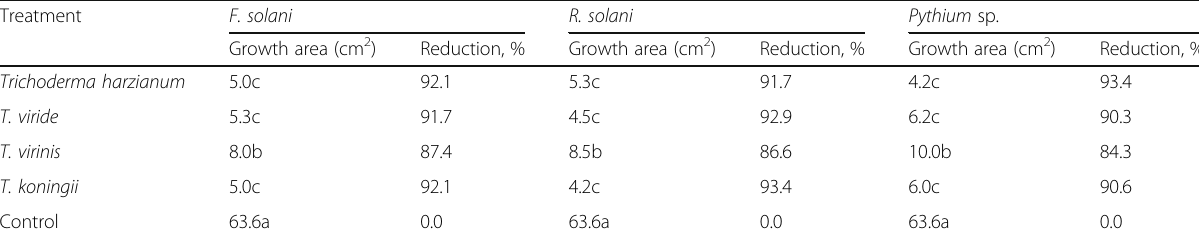
Table 1 Effect of four Trichoderma spp. on growth area of strawberry black root rot disease Treatment